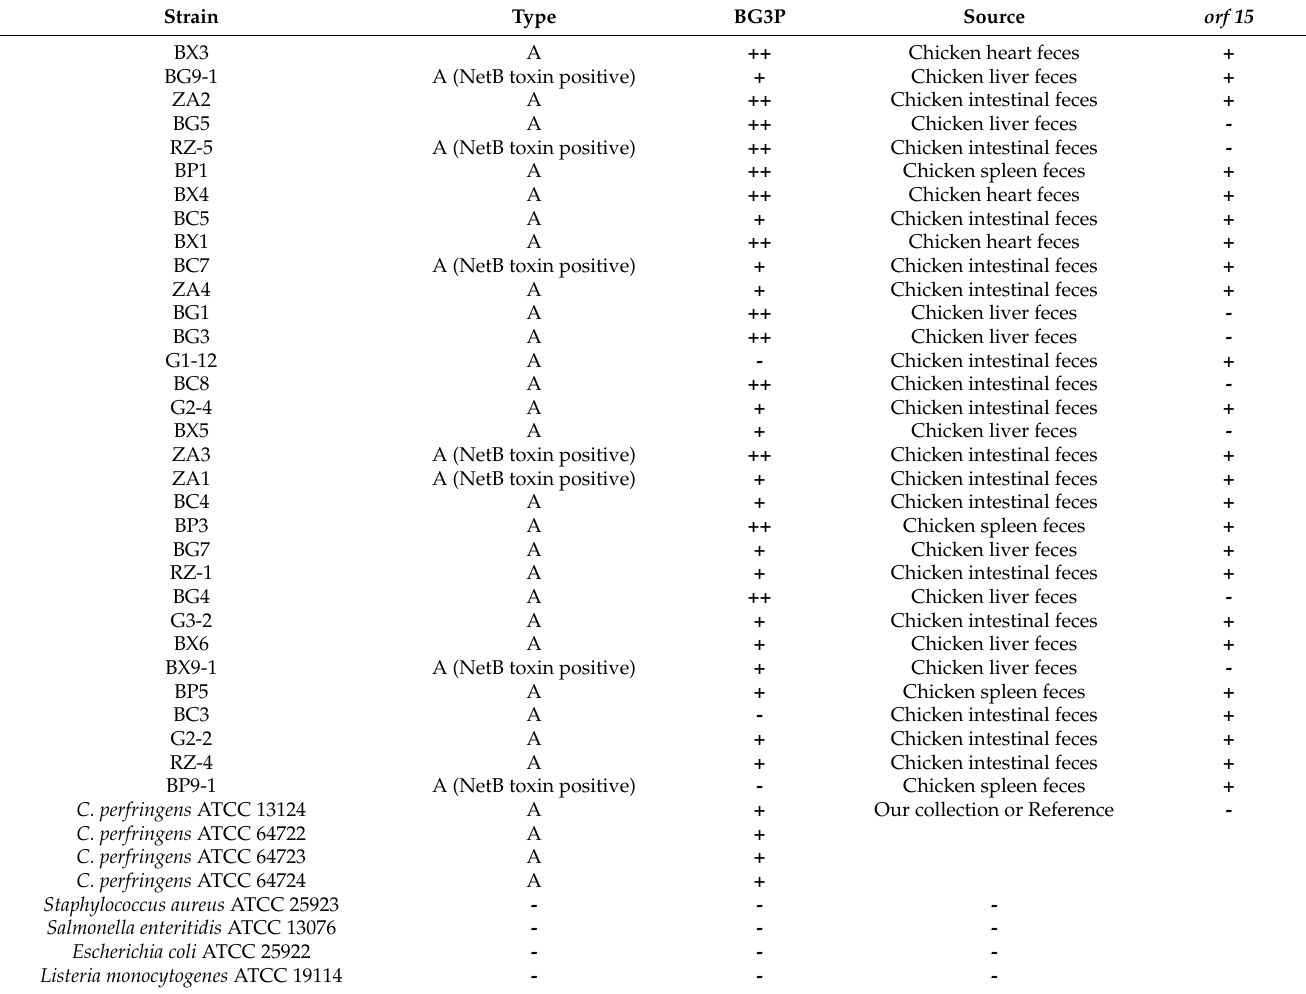
“++” transparent, “+” semi-transparent, “-”